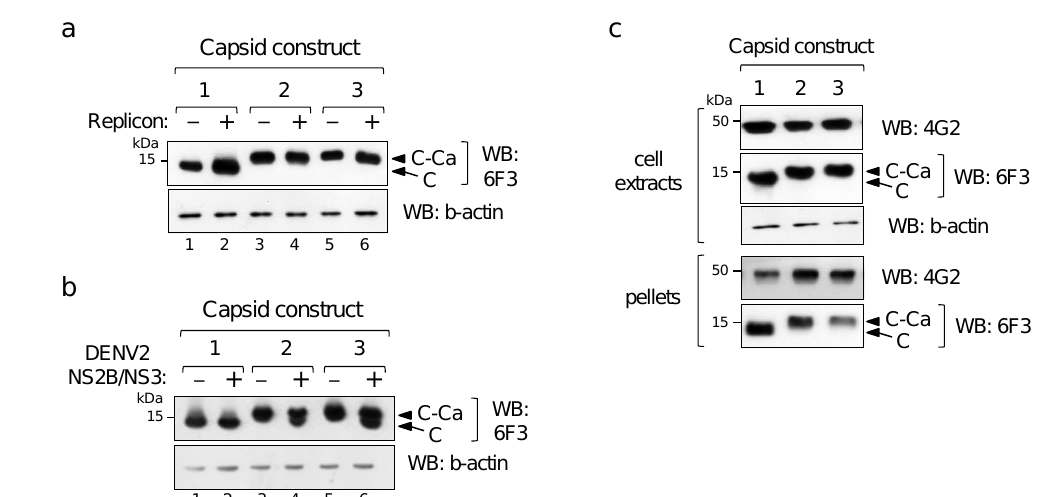
Figure 2. Processing by viral proteases. ( a , b ) Western blot of extracts of cells co-transfected with the indicated capsid constructs (shown in Figure 1) in the absence ( − ) or presence ( + )of WNV replicon ( a ) or DENV2 NS2B / NS3 protease ( b ). ( c ) Western blot of cellular extracts and viral particles pelleted from culture supernatants (pellets) from cells producing pseudovirus particles, revealed with mAbs 4G2 for protein E and 6F3 for C, respectively. β-actinwas used as the loading control.